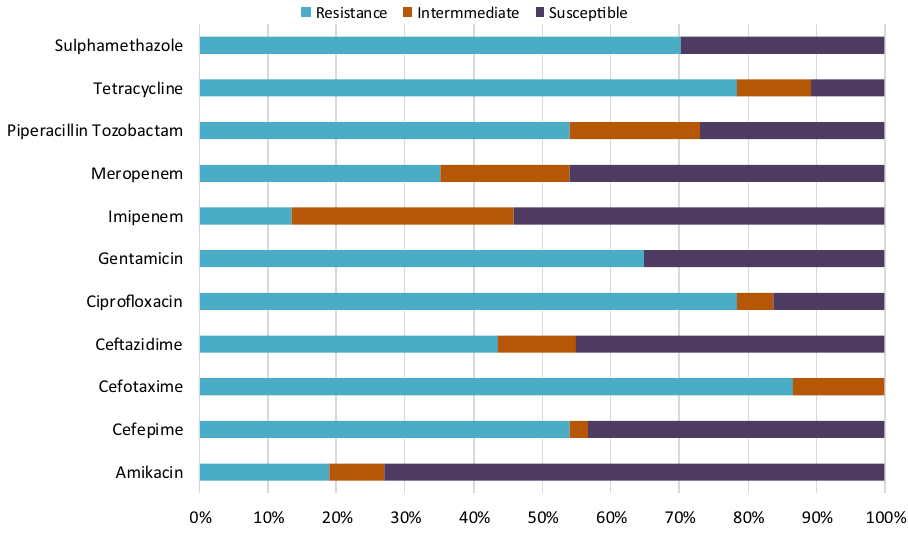
Figure 2. Antibiotic sensitivity pattern of class 1 integron MDR Acinetobacter